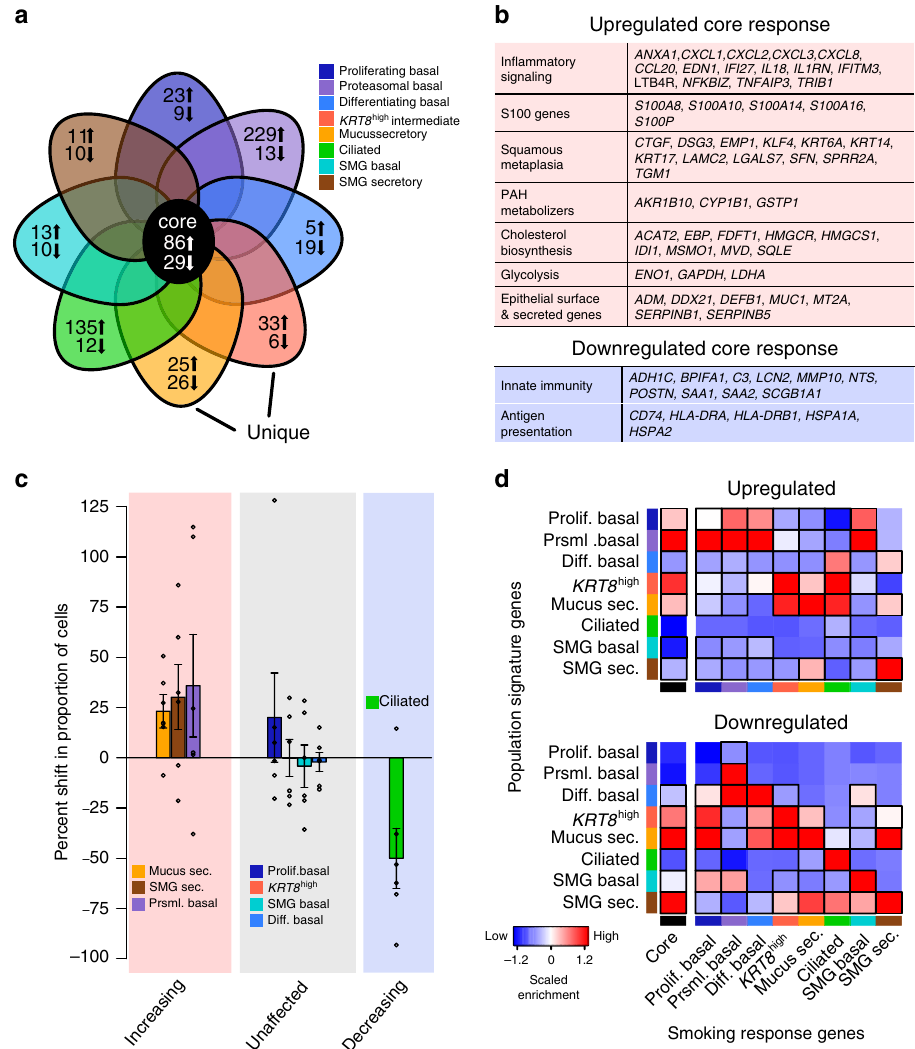
Fig. 2 Smoking induces both shared and unique responses across cell types that decrease functional diversity of the epithelium. a Schematic Venn diagram summarizes core and unique smoking responses across eight broad cell populations, with number of upregulated and downregulated genes unique to populations given in the tips and number of core genes affected in ≥ 5 populations in the center. Note degree of overlap in the diagram is not proportional to gene overlap for readability. Detailed percentages in Supplementary Fig. 3b. b Denoted key pathways and genes comprising the core upregulated and downregulated smoking response. c Relative proportions of broad cell populations shift with prolonged smoke exposure. Average and standard error of percent shift in proportion are shown for smokers ( n = 6) relative to non-smokers ( n = 6). Points show percent shifts for each individual smoker donor relative to the mean proportion across non-smokers. d Enrichment of cell-type signature genes from non-smokers (rows) in core and non-core smoking response genes for each of the broad cell populations (columns), based on hypergeometric tests. Color of box depicts scaled level of enrichment ( − log10 of FDR-adjusted p -value), black outline of box indicates signi fi cant enrichment at FDR < 0.05. See also Supplementary Figs. 3 and